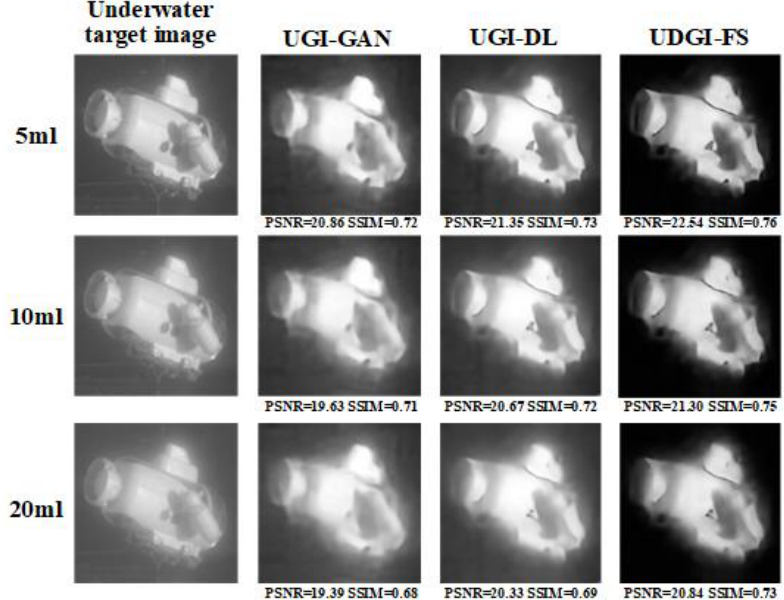
Figure 19. Comparison of reconstructed submarine images of UDGI-FS, UGI-DL, and UGI-GAN at different degrees of underwater blurring.